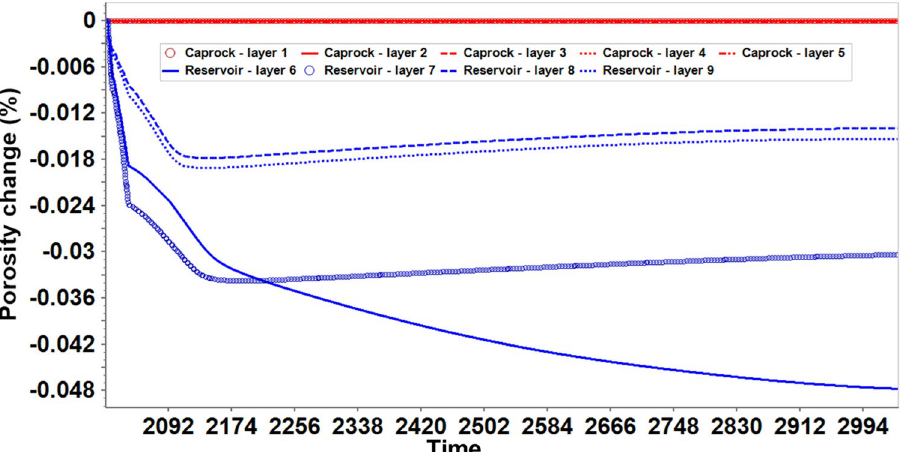
Figure 8. The porosity changes along the injector wellbore grid blocks during 1000 years of post-injection monitoring, showing that the reaction in upper reservoir layers (layer 6 and 7) is more significant than in the bottom reservoir layers (layer 8 and 9); The reaction barely affected the porosity in caprock layers (layer 1 to 5).